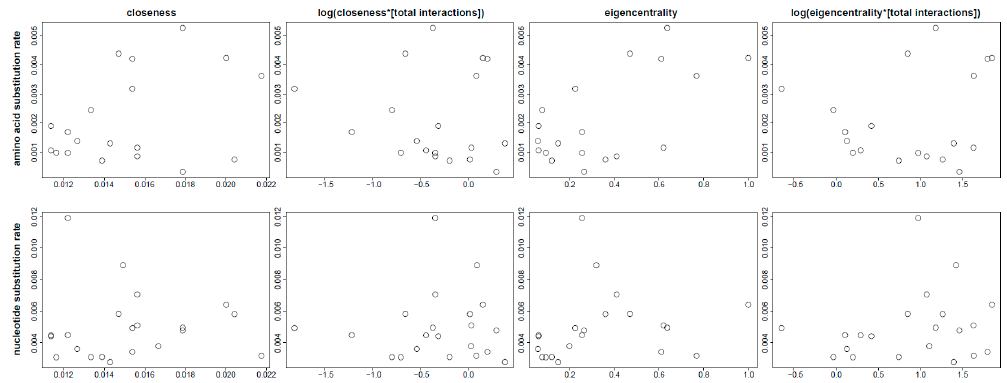
Figure 6. Biplots of the correlation between different measures of node importance in the interaction network of sperm individualization genes and their amino acid evolutionary rates in insects (top panels) and nucleotide substitution rates in beetles (bottom panels).